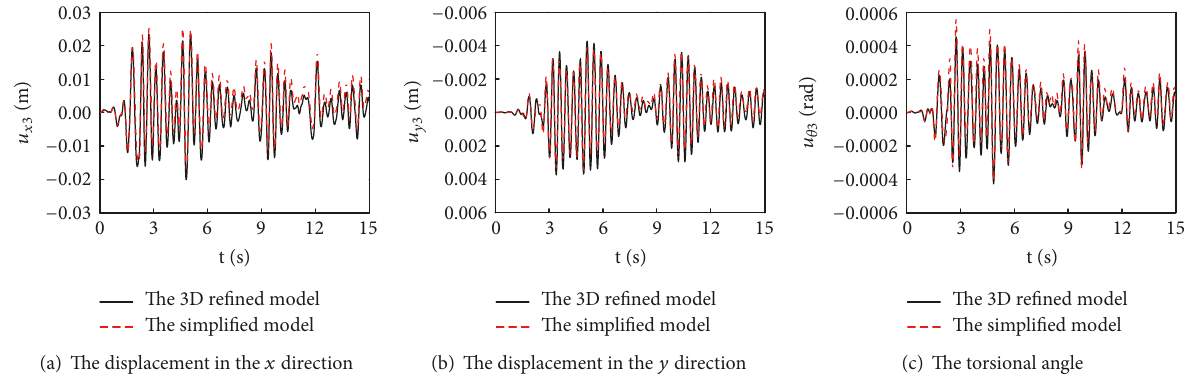
Figure 24: The top floor displacement curves at the center of mass under rare earthquake (EL-Centro